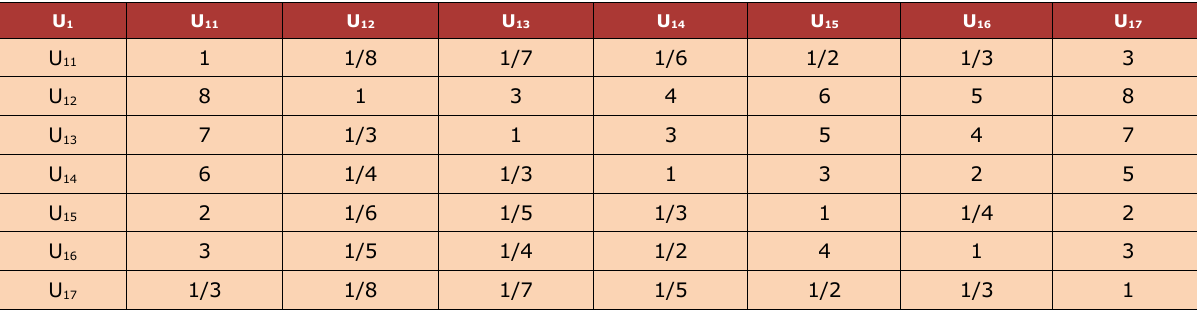
Table 3. The judgment matrix of internal operation performance indicators